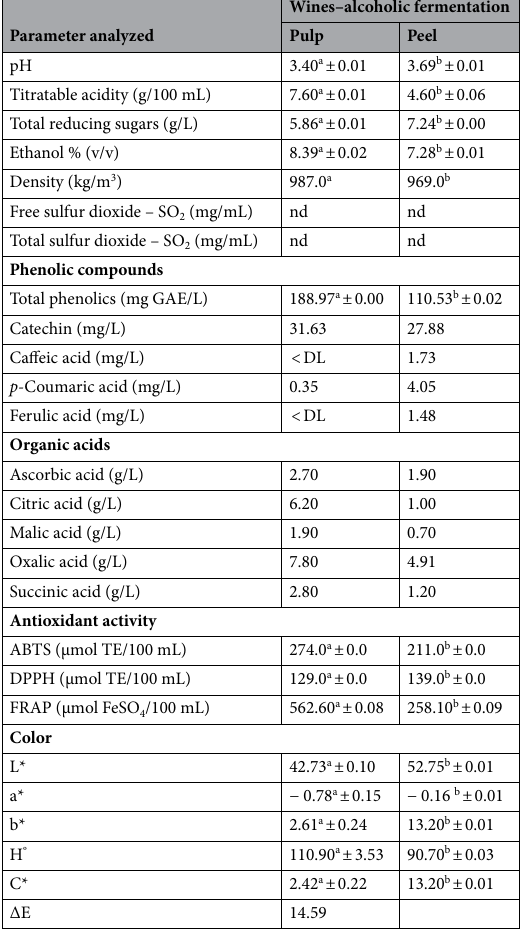
Table 3. Physicochemical and bioactive parameters of pineapple pulp and peel